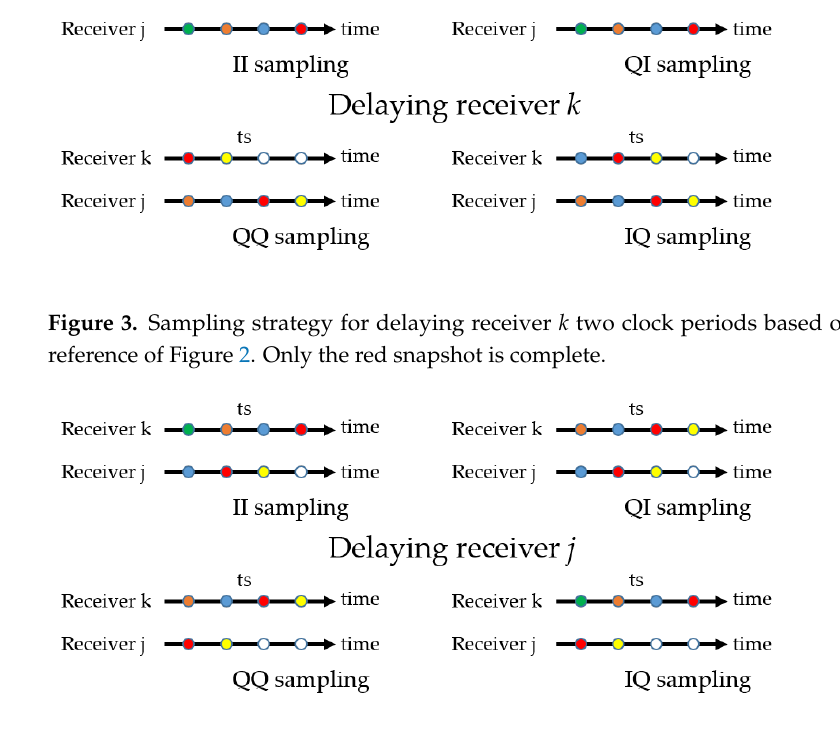
Figure 4. Sampling strategy for delaying receiver j two clock periods based on the non-delayed reference of Figure 2. Only the red snapshot is